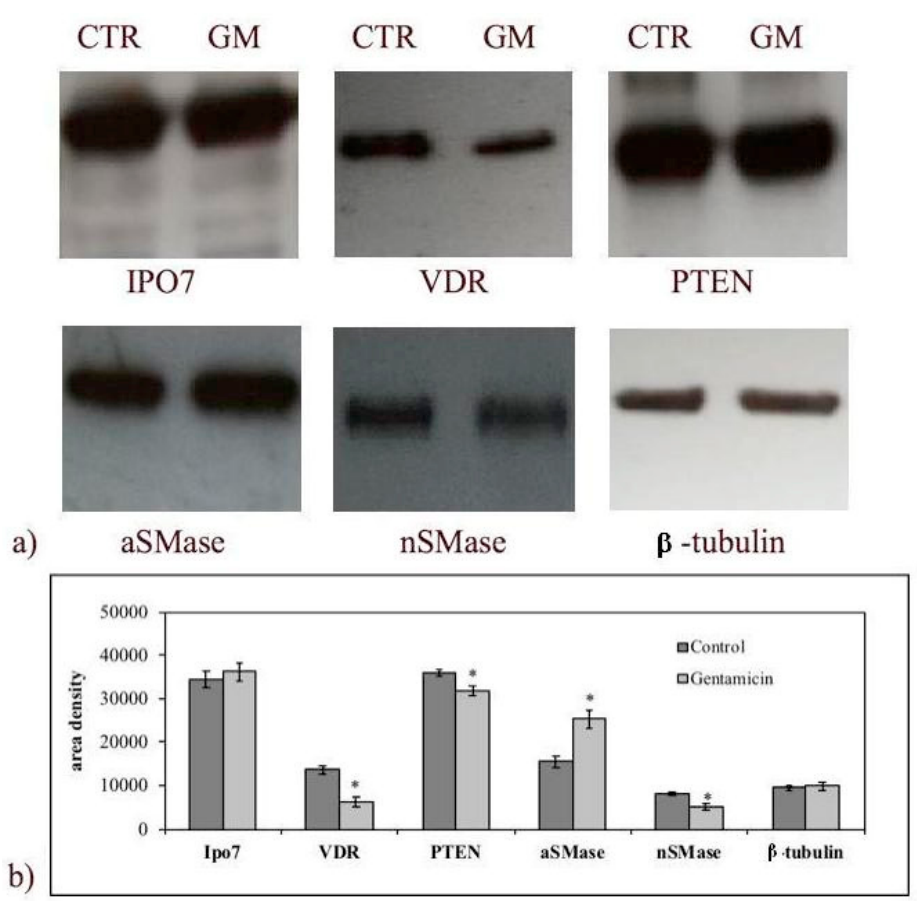
Figure 4. Effect of gentamicin on importin 7 (Ipo7), vitamin D receptor (VDR), phosphatase and tensin homolog deleted on chromosome 10 (PTEN), acid sphingomyelinase (aSMase), and neutral sphingomyelinase (nSMase) protein expression. Experiments were performed in control and experimental NCI-N87 cells collected 24 h after 1.5 mM GM treatment. ( a ) Immunoblots of proteins were probed with anti-IPO7, anti-VDR, anti-PTEN, anti-aSMase, and anti-nSMase and visualized by enhanced chemiluminescence (ECL). β -tubulin was used as loading control. ( b ) The area intensity was evaluated by densitometry scanning and analysis with ImageJ program, the data represent the mean ± SD of three experiments performed in duplicate (significance, * p < 0.001 versus control